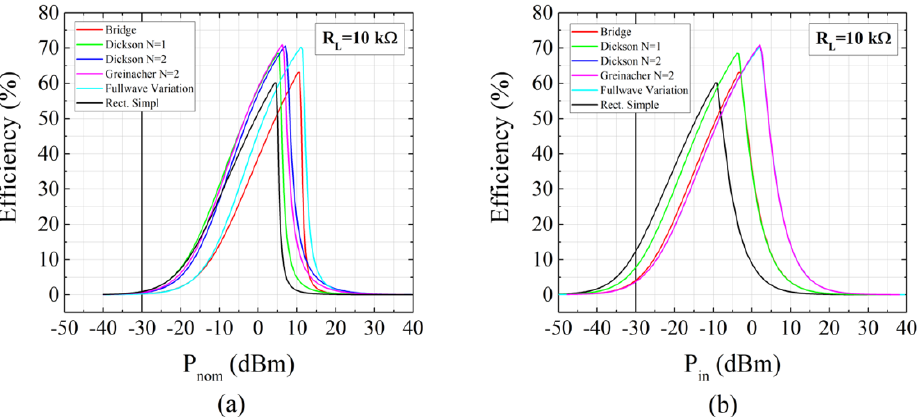
Figure 3. Simulated rectifier efficiency for the six circuits in Table 1 as a function of P nom in ( a ) and as a function of P in in ( b ).